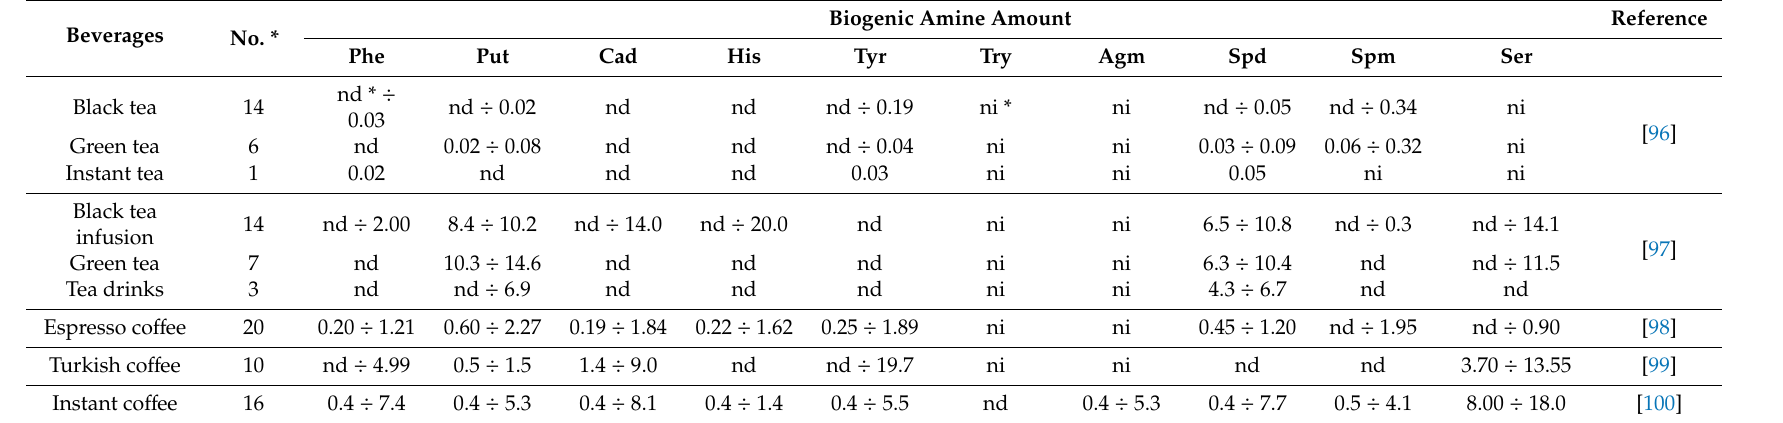
Table 5. Biogenic amine amount in nervine beverages (mg /